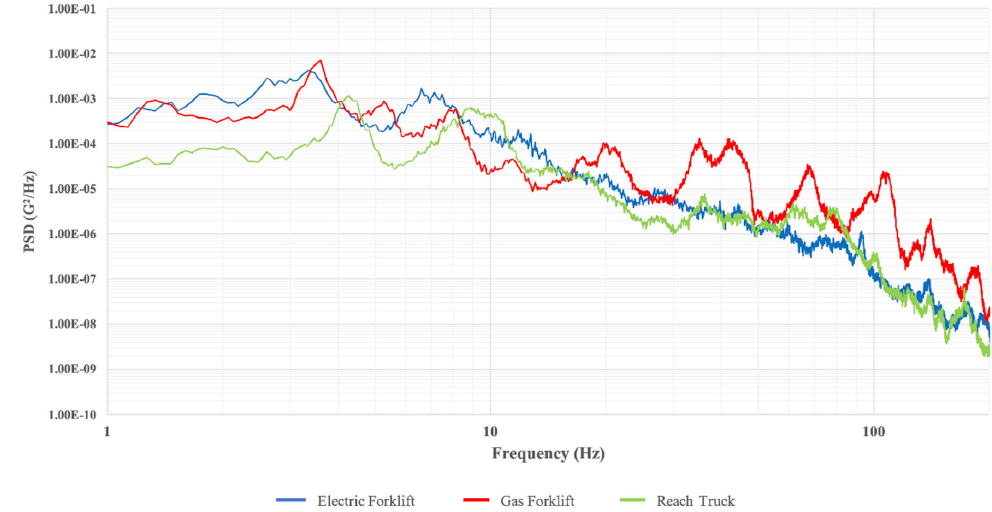
Figure 10. PSD plots of the three investigated forklifts: gas-powered forklift, electric forklift, and reach truck.